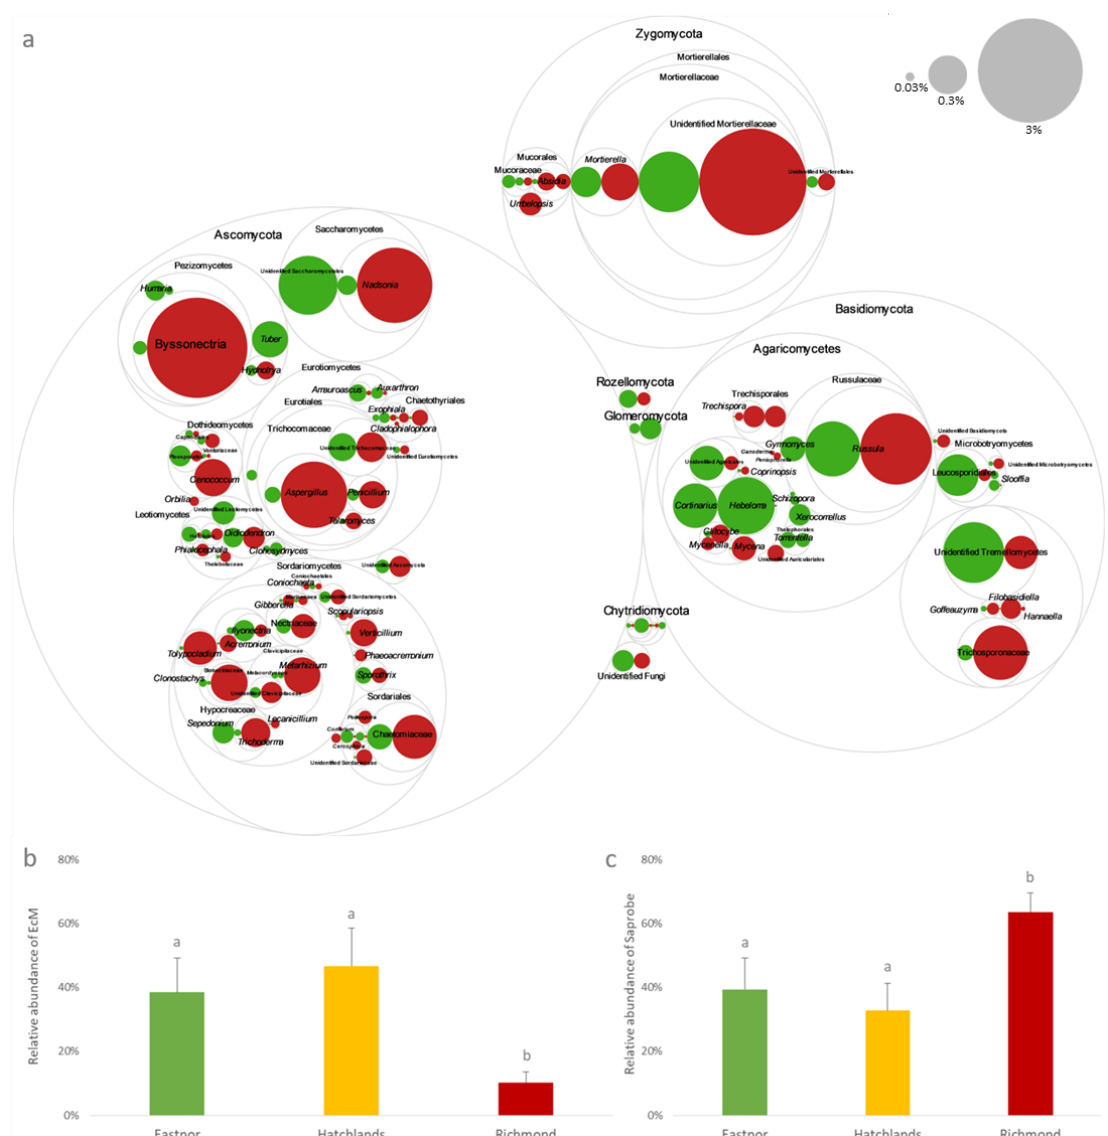
Figure 6. Fungi differentially abundant across the sites ( a ). Only significantly enriched OTUs determined by DESEq 2.0 are depicted (FDR-corrected p < 0.05). The size of the circles represents the relative abundance (scale represented by gray circles) and the colour denotes the rhizosphere of oak trees located in Eastnor (green) or Richmond (red) only. Ecological guilds of fungal taxa detected in the rhizosphere soils in Eastnor, Hatchlands, and Richmond ( b and c ). Significant differences ( p < 0.05) according to the site are indicated by different letters. EcM—ectomycorrhizal fungi ( b ); saprobe—saprophytic fungi ( c ). As revealed above by dbRDA and PERMANOVA, healthy trees held di ff erent microbial compositions compared to AOD trees at Eastnor and Hatchlands. Accordingly, the di ff erential abundance analysis (DESeq 2.0) detected 848 bacterial and 70 fungal OTUs more abundant in